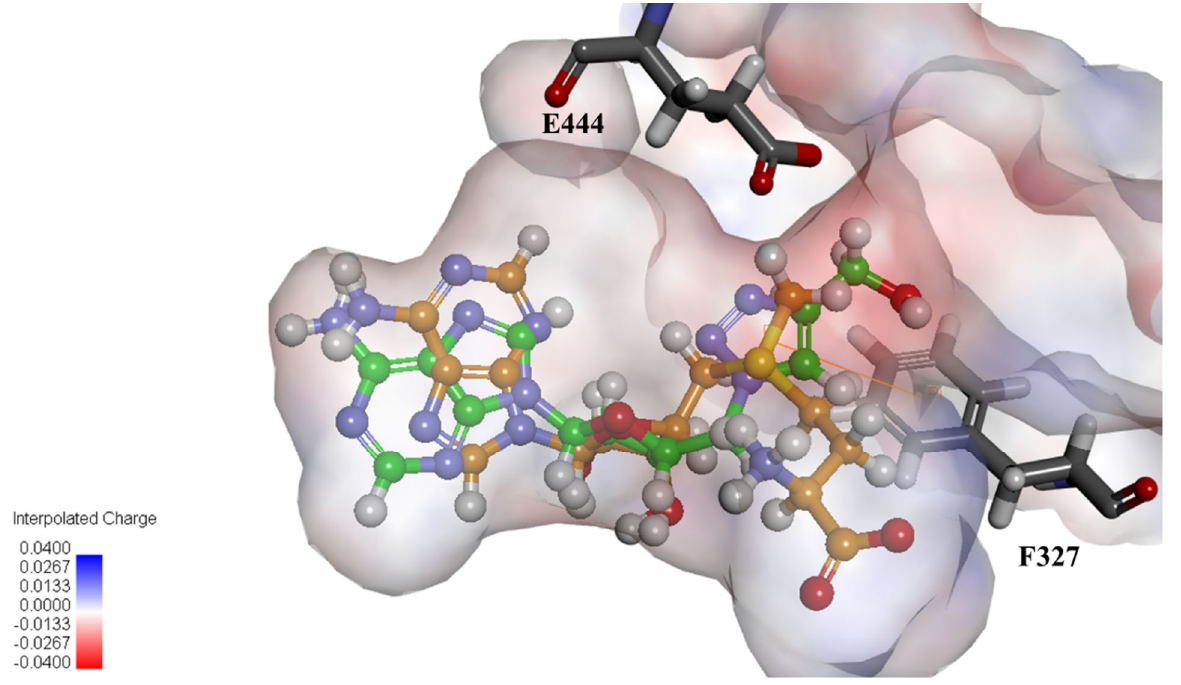
Figure 3. Overlay of docked SAM (orange) and 3 (green) showing the position of the triazole ring in relation to the sulfonium portion of SAM.